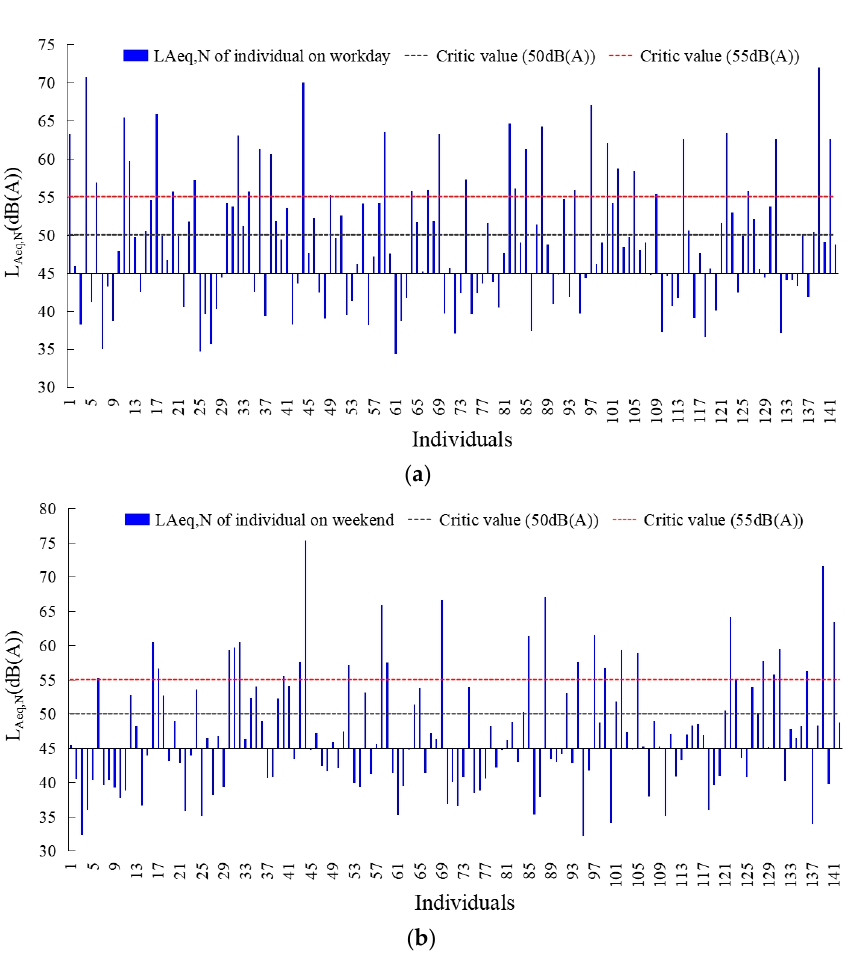
Figure 4. Environmental noise exposure values of residents during daytime on workdays and week- ends. ( a ) Workday; ( b ) weekend.